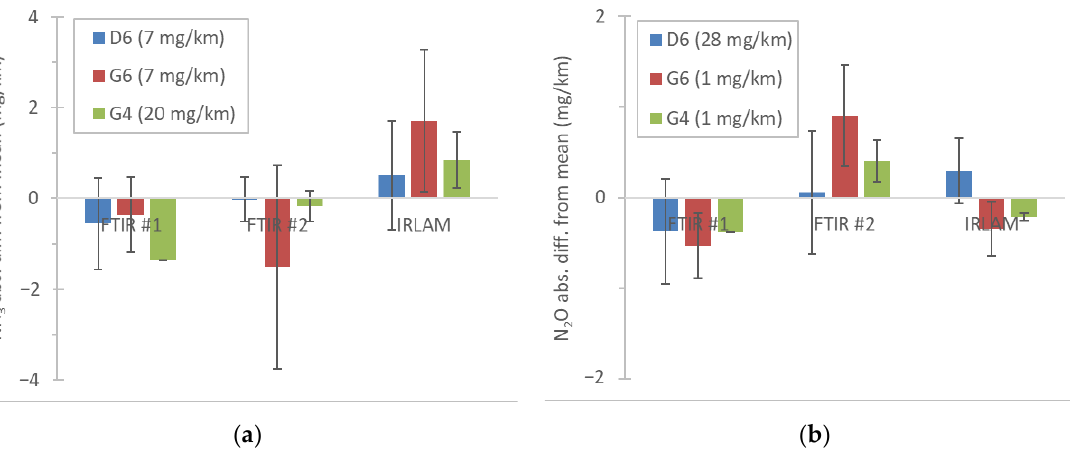
Figure 10. Absolute differences of the instruments from their mean: ( a ) NH 3 ; ( b ) N 2 O. Each colored bar is a vehicle: Diesel Euro 6 (D6), gasoline Euro 6 (G6); gasoline Euro 4 (G4). Numbers in brackets are the average absolute emission levels. Error bars give one standard deviation or max-min in the case of the G4.